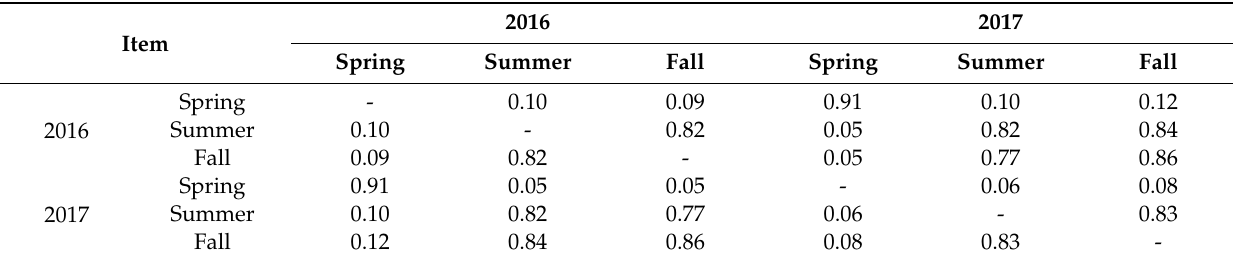
Table 6. Diet overlaps of goats browsing a Southern Mediterranean forest rangeland during 2016 and 2017.